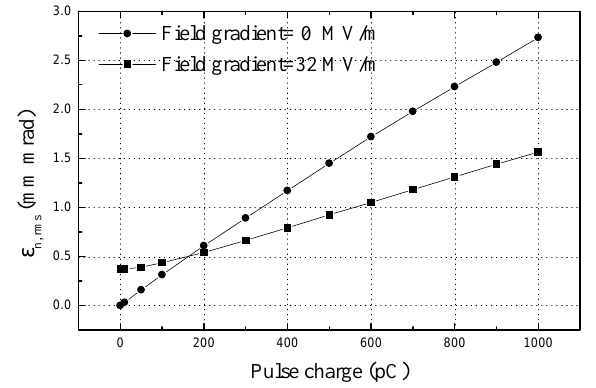
FIG. 11. Emittance growth in the PWT structure with beam pulse charge.